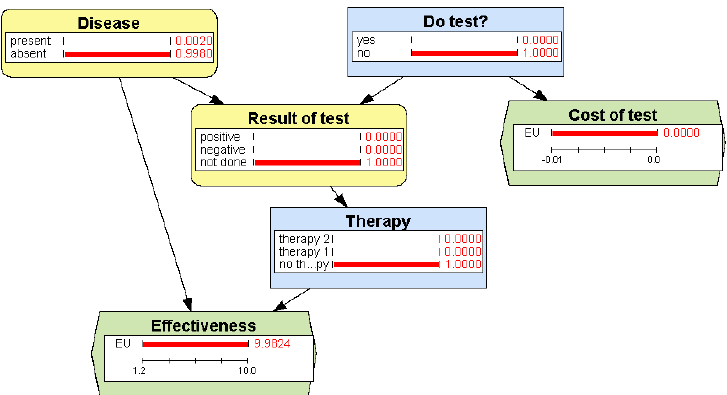
Figure 12. What-if reasoning: OpenMarkov allows the user to analyze what would happen if the decision maker applied a non-optimal policy. The node Therapy is colored in dark blue to indicate that a policy was imposed, instead of allowing the evaluation algorithm find the optimal strategy.